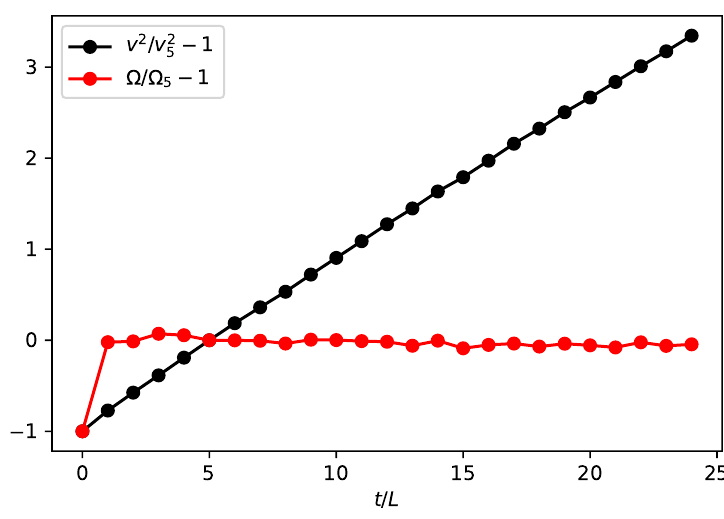
Figure 3 . Characteristics of the F i -driven vorticity injection for a single realisation of a turbulent black brane horizon. Black points show the growth of kinetic energy with time, normalised by the kinetic energy at t = 5 L . This is consistent with a key assumption of the K41 dimensional analysis: that the relevant scale is a constant kinetic energy per unit time, ε . As further support we also show the approximate constancy of the total enstrophy of the system in